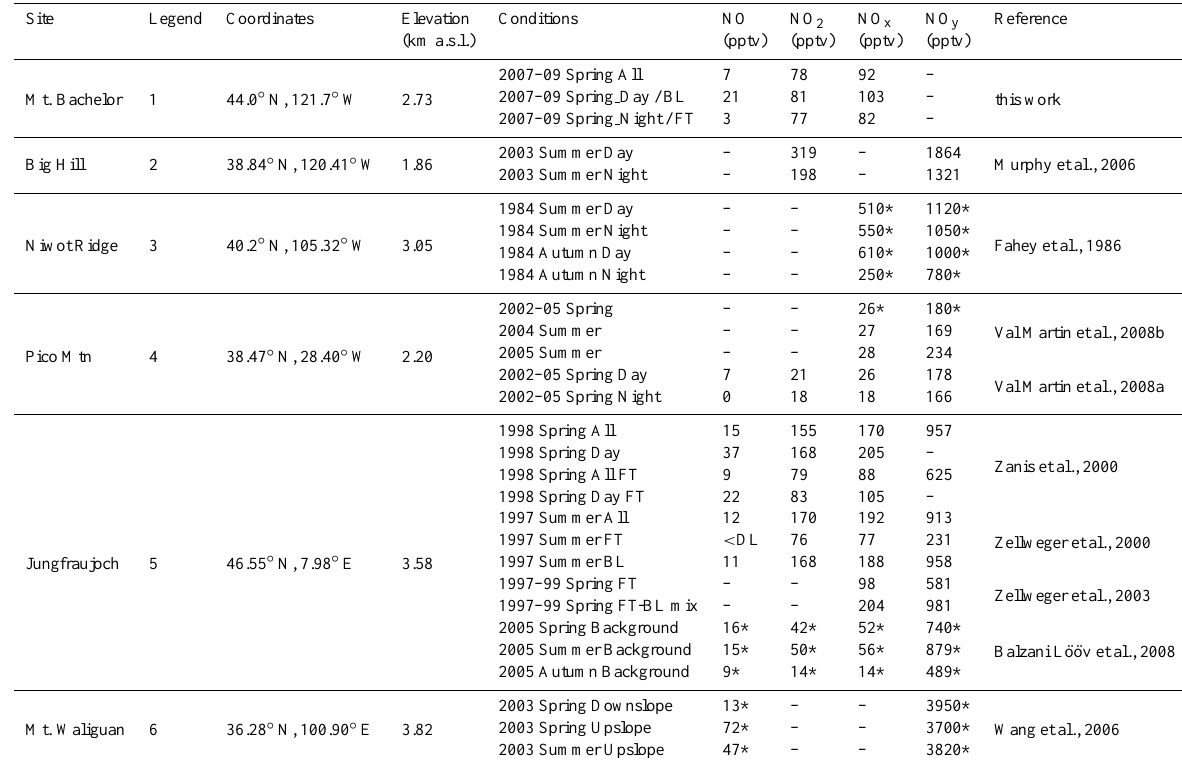
Table 3b. Details for the mountain sites depicted in Fig. 6 with corresponding NO, NO 2 (NO x ) and NO y data where available. Values with an asterisk (*) are means; all other values are